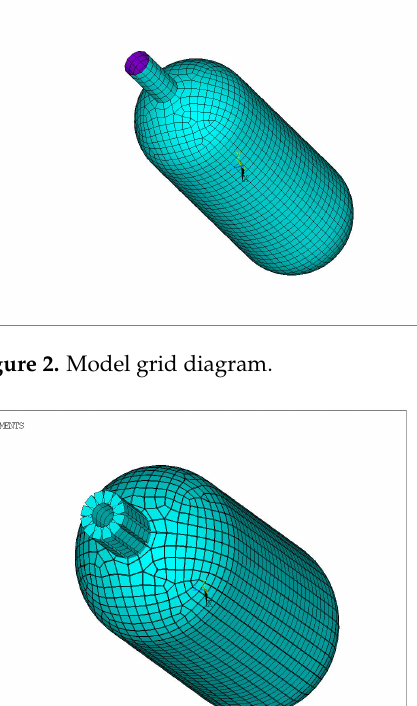
Figure 3. Fiber layer grid diagram.